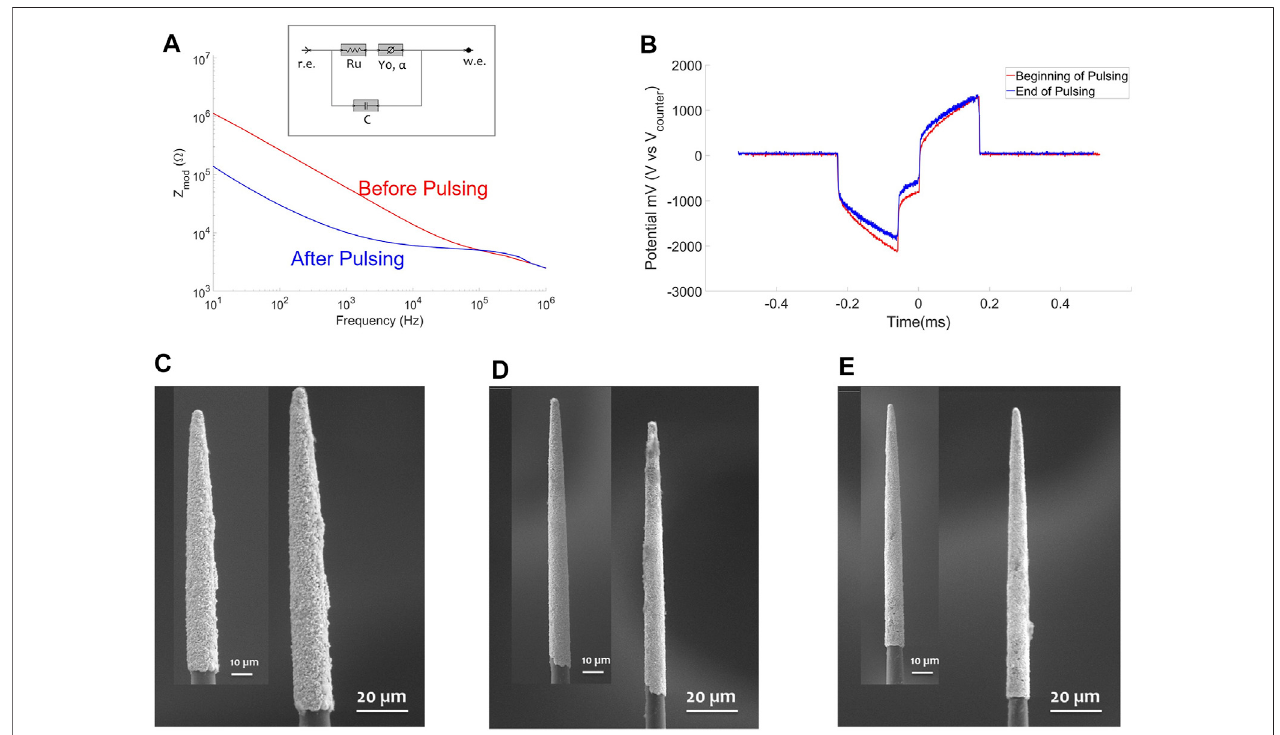
FIGURE5| 300 HzElectricpulsetest. (A) EISofonePtIr-CFbefore(redsolidline)andafter(bluesolidline)pulsingonDay1;asinsetthecircuitmodelusedfor fi tting impedance data is shown. (B) Voltage transient for one PtIr-CF in the beginning (red) and at the end of pulsing test (blue); a biphasic pulse of 170 μ s duration and amplitude of 105 μ A (1 mC/cm 2 ) was applied. (C – E) SEM of three PtIr-CF before as inset and after 12 h of pulsing